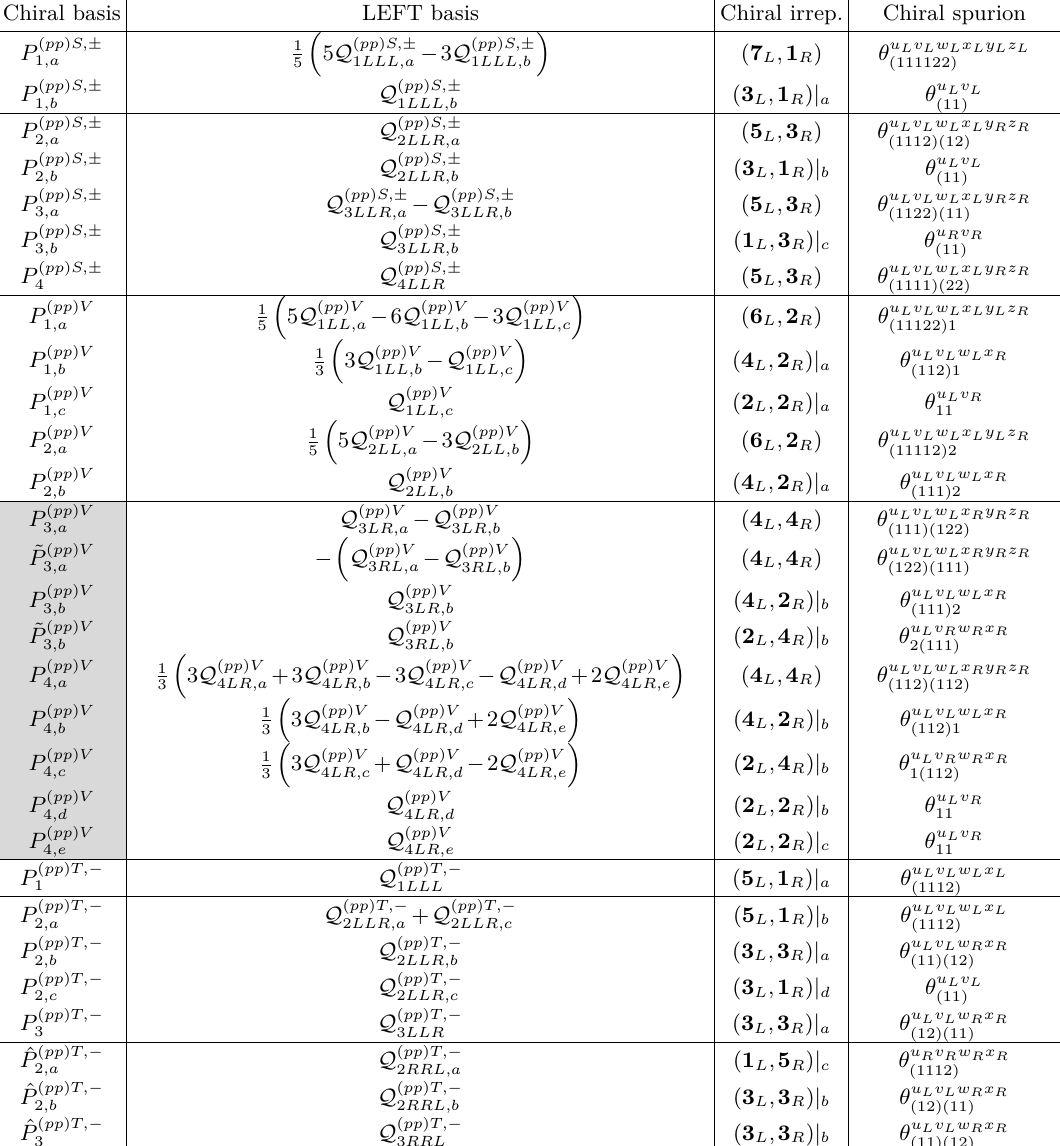
Table 5 . The chiral basis and their chiral irreps under G χ for the operators contributing to pp → ‘ + ‘ 0 +